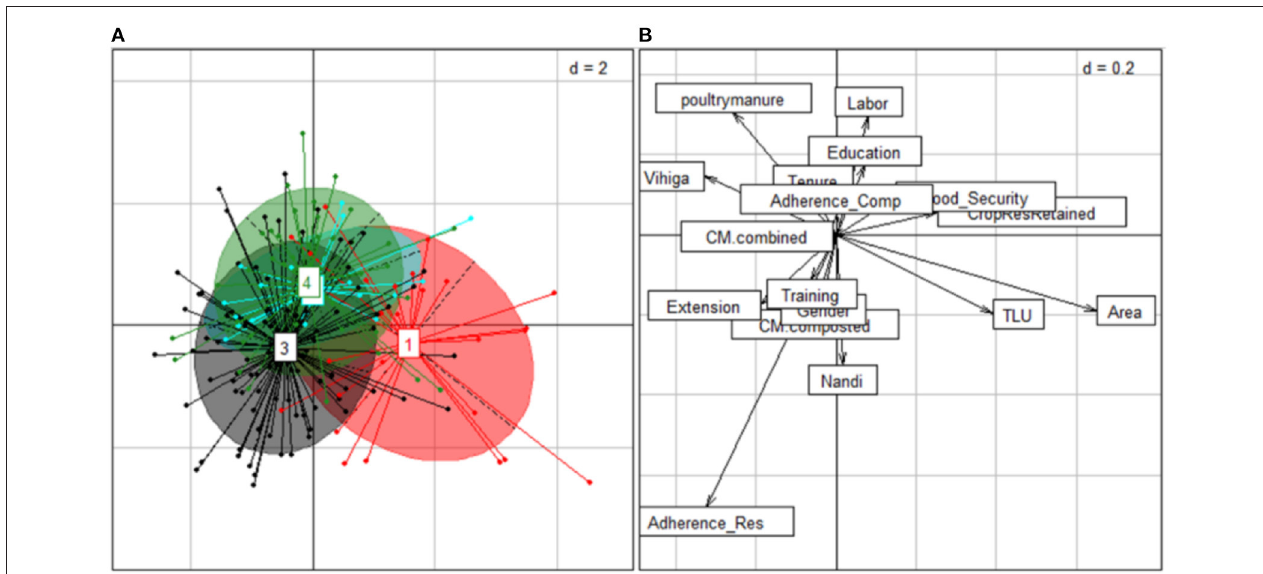
FIGURE 5 | Between class analysis (BCA) showing group separation [ (A) group classes and (B) arrow linking points to origin] for constructed farm typologies in organic nutrient sources management in three counties in western Kenya. The groups 1–4 are constructed farmer types of ONS management (see Table 9 ). TLU is Tropical Livestock Units; Area is area of main plot; Nandi/Vihiga are counties in western Kenya; Education is the education level of household head; CM, combined; CM, composted and Crop; Res, Retained; represent the proportion of cattle manure not composted and composted and crop residues that were allocated to main plot, respectively; Adherence_Res and Adherence_Comp refers to adherence to social norms of crop residue and compost management, respectively; Extension is the number of times a farmer had interactions with extension agents in the previous year; Food-Security refers to how many months in a year that farmers felt they